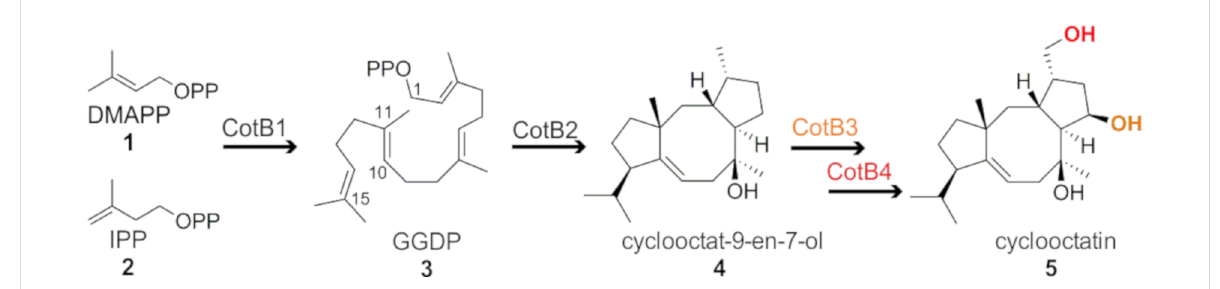
Figure 1: CotB1 synthesizes geranylgeranyl diphosphate (GGDP) 3 from the substrates dimethylallyl diphosphate (DMAPP) 1 and isopentenyl diphosphate (IPP) 2 . The acyclic substrate GGDP ( 3 ) is stereospecifically cyclized by CotB2 to cyclooctat-9-en-7-ol ( 4 ), with a fusicoccane 5–8–5 fused ring system. Two cytochrome P450 enzymes, CotB3 and CotB4, subsequently functionalize cyclooctat-9-en-7-ol ( 4 ) to the bioactive compound cyclooctatin ( 5